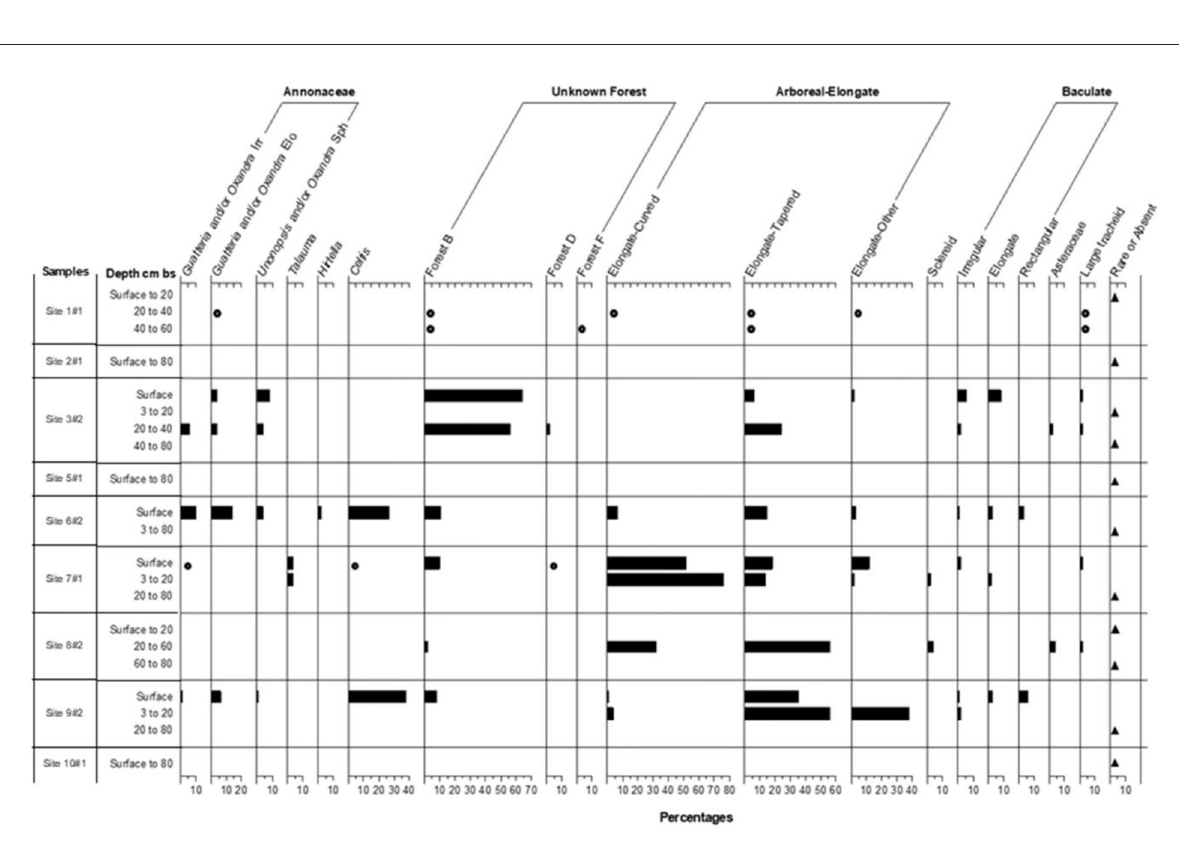
FIGURE5 Percentage frequencies of phytoliths in the sand fractions of the soils at the ten